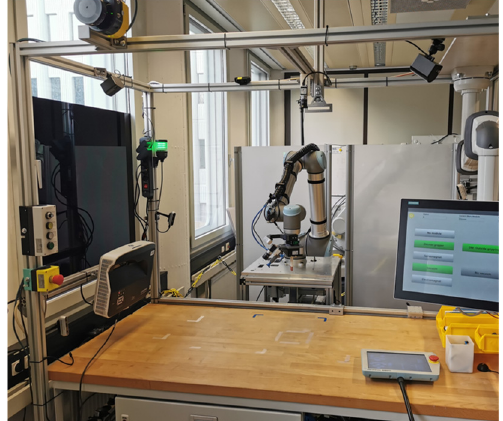
Figure 8. Robot cell for the evaluation of the multimodal interface. For ensuring safe collaboration, a UR10 robot and a Sick microscan3 were integrated in the cell. Moreover, a Siemens SIMATIC™ HMI Unified Control Panel was added to display the Web UI.